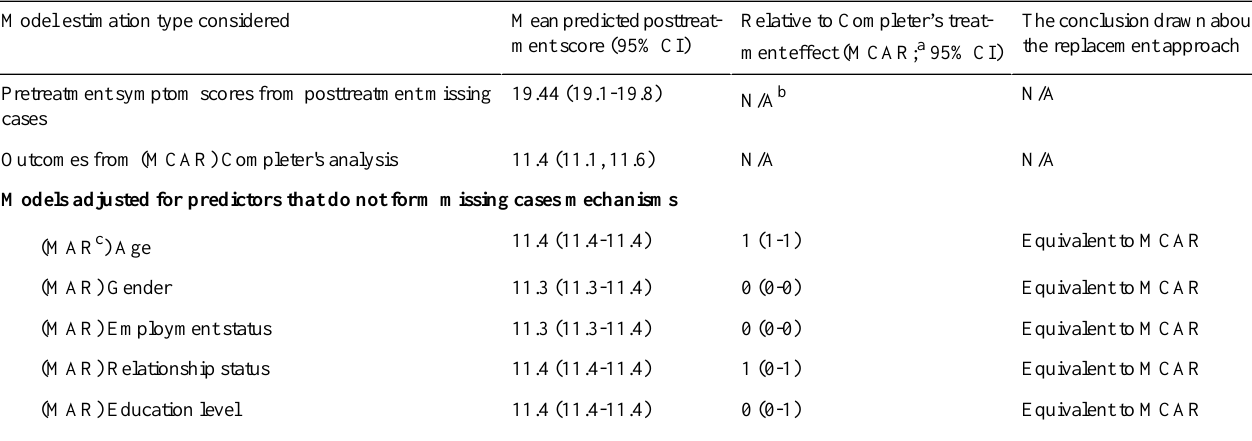
Table 9. Predicted Kessler-10 outcomes generated with different replacement models—compared with average posttreatment model estimate (missing completely at random).